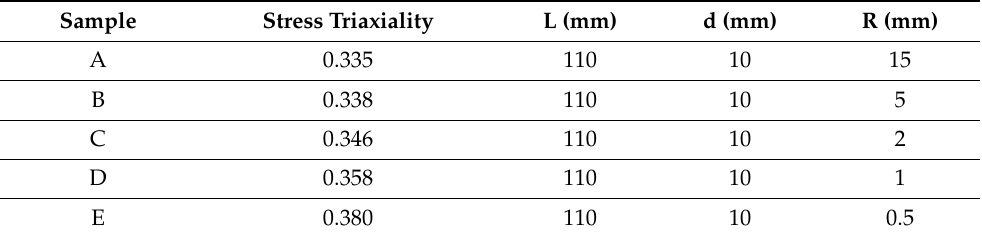
Figure 5. Geometry of tensile samples used to obtain the parameters of JC plasticity and damage models. Table 3. Dimensions and stress triaxiality of tensile samples (shown in Figure 5) used to obtain the parameters of JC plasticity and damage models.